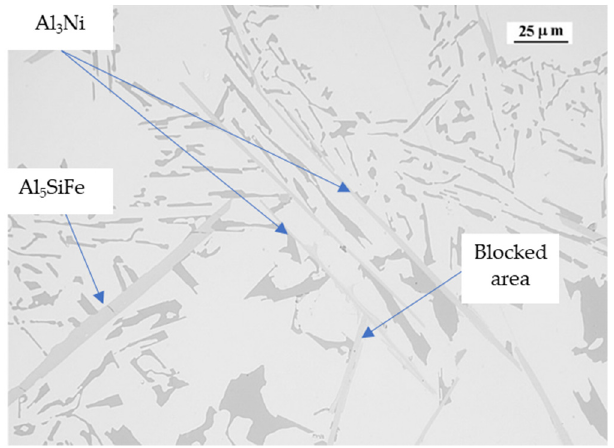
Figure 11. Alloy 6 micrography showing the Al 5 SiFe and Al 3 Ni phases and a blocked area.